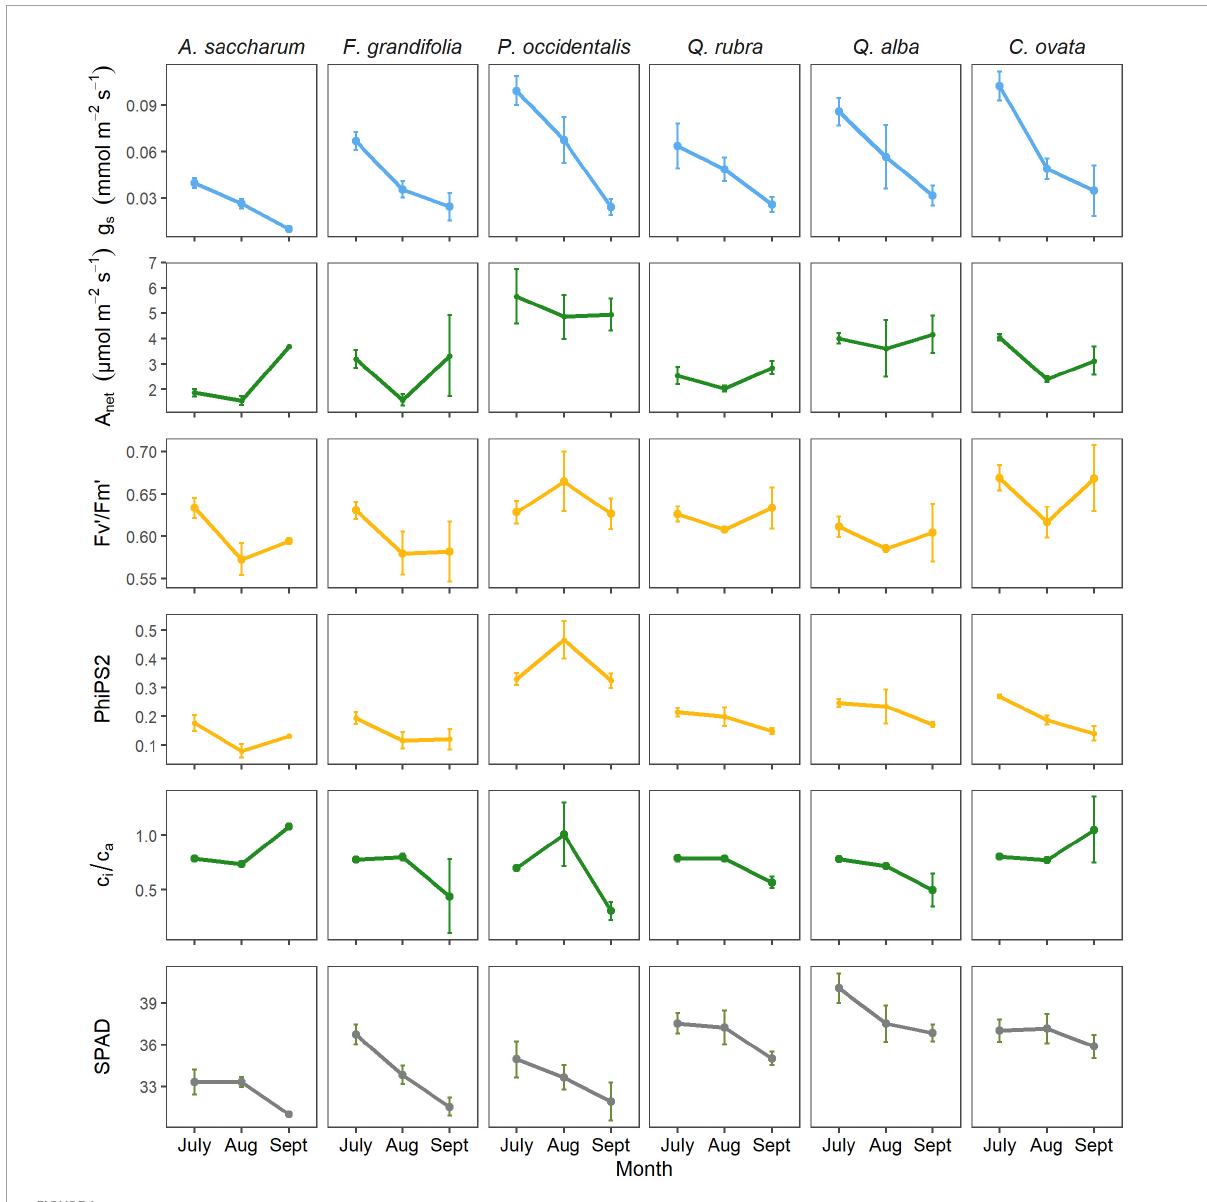
FIGURE1 Mean (+/-SE) physiological variables (collected at midday) indicating environmental stress responses among six temperate juvenile trees during summer in 2019. From top to bottom: g s (stomatal conductance); A net (net rate of photosynthesis); F v ’/ F m ’ (maximum quantum capacity of photosystem II); PhiPS2 (actual quantum efficiency of photosystem II); c i / c a (ratio of intercellular carbon to atmospheric carbon; and SPAD reading (unitless; representing chlorophyll content). Patterns and rates of parameters varied seasonally by